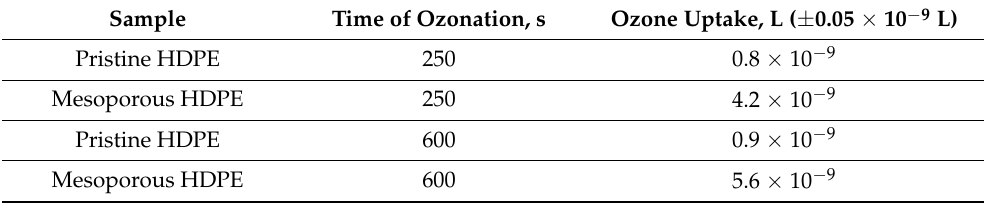
Table 1. Ozonation of pristine HDPE and mesoporous HDPE